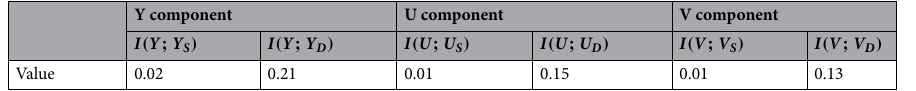
Table 2. Shannon mutual information measure. The experimental results are obtained on the DRIVE dataset 35 .